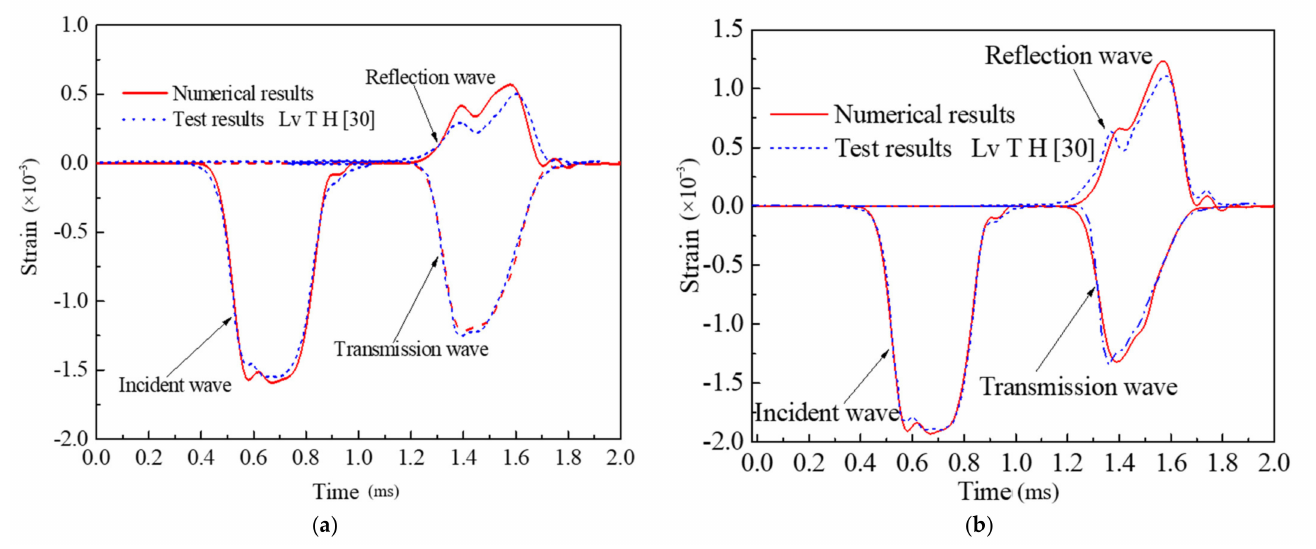
Figure 6. Waveform validation ( a ) impact velocity of 15.33 m/s; ( b ) impact velocity of 18.58 m/s.